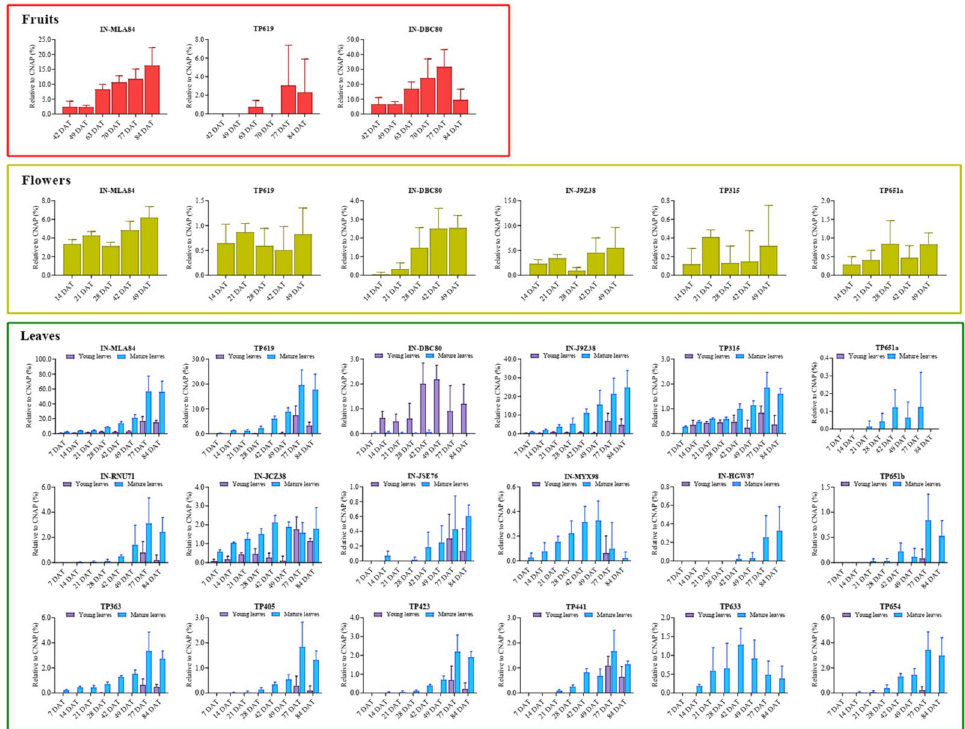
Figure 3. Relative abundances of cyantraniliprole metabolites detected in tomato leaves, flowers, and fruits throughout the experiments. For flowers, the metabolites that were only detectable in the concentrated